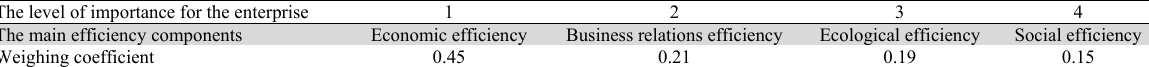
Evaluation of the main components priority level of the studied enterprise efficiency with the group significance criteria №